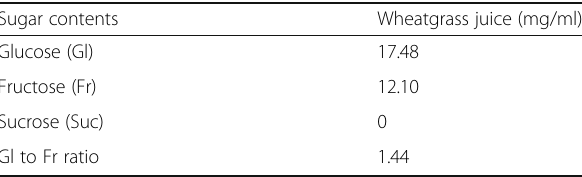
Table 5 Glucose, fructose, and sucrose analysis by HPLC in wheatgrass